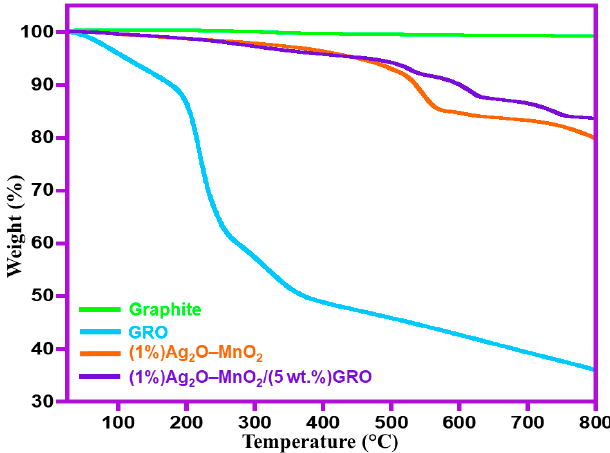
Figure 1. XRD analysis of the graphite, GRO, (1%)Ag 2 O–MnO 2 , and (1%)Ag 2 O–MnO 2 /(5 wt.%)GRO. GRO: graphene oxide.